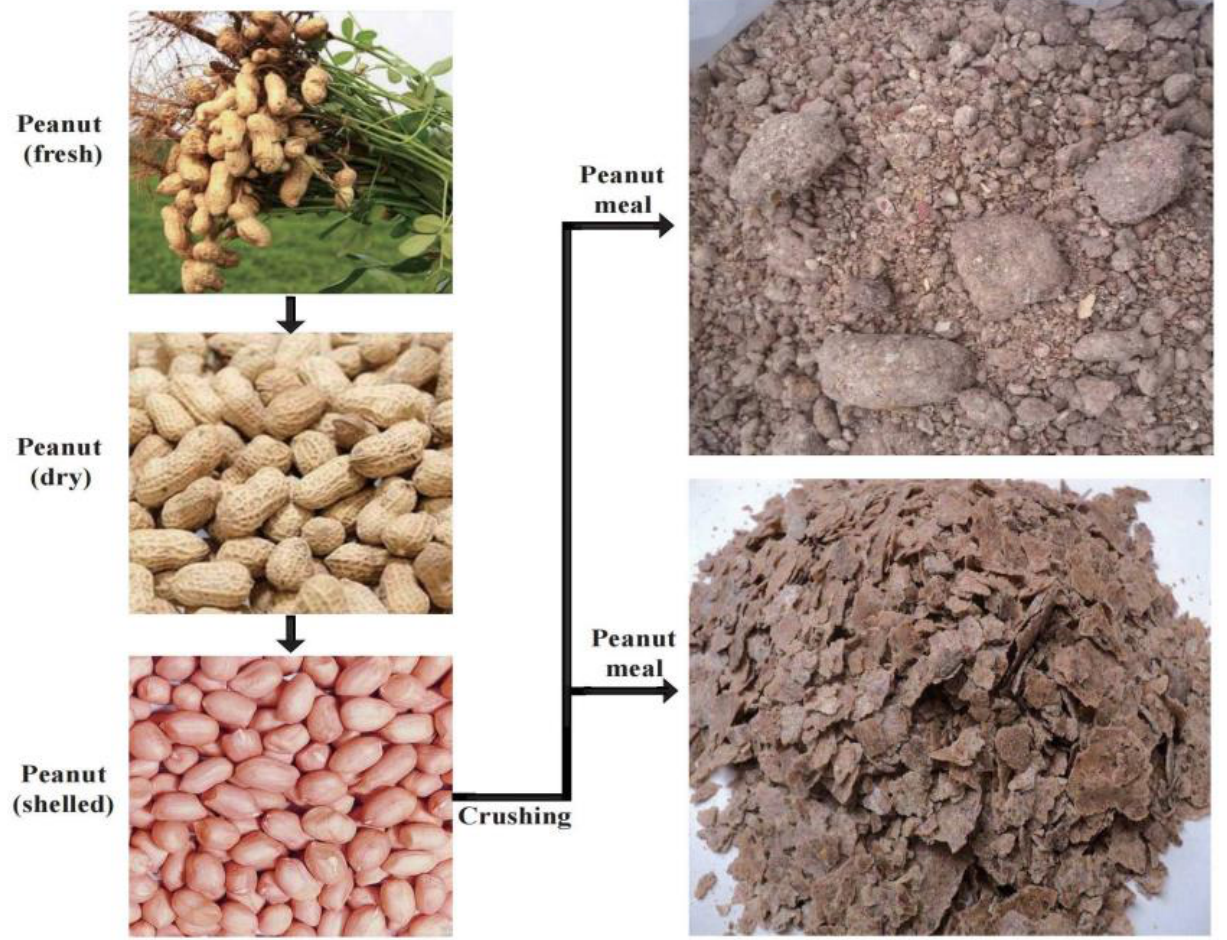
Figure 1. The production process and two main morphological forms of PNM.